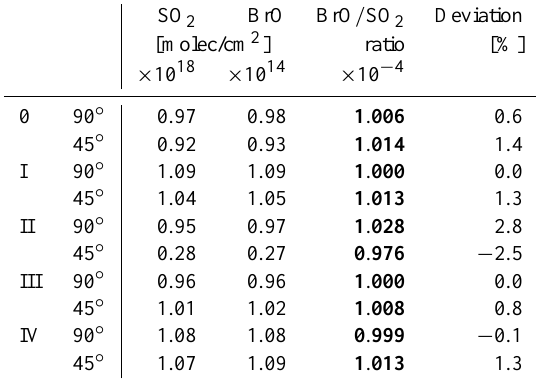
Table 1. SO 2 CDs, BrO CDs and the BrO / SO 2 ratios for the different cloud scenarios and a cloud optical density of 4 at 340nm. (0) is a cloud-free atmosphere, (I) a cloud layer between 5.5 and 6.5km, (II) a cloud layer between 5 and 5.5km, (III) a cloud layer between 6.5 and 7km, and (IV) an enhanced aerosol abundance coinciding with the volcanic plume. SO 2 BrO BrO / SO 2 Deviation [molec/cm 2 ] ratio [%]